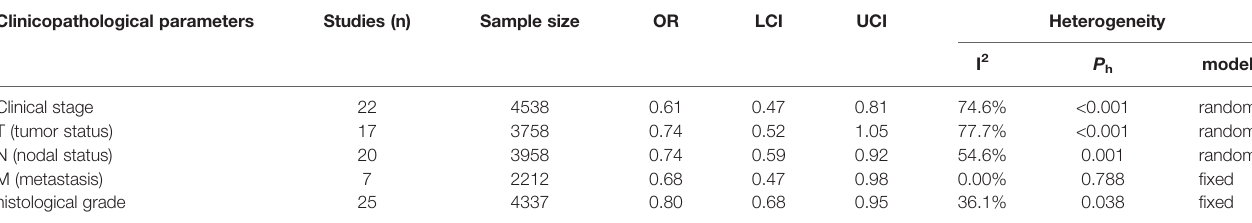
TABLE 2 | Meta ‐ analysis of the relationship between HLA-G expression and clinicopathological parameters. Clinicopathological